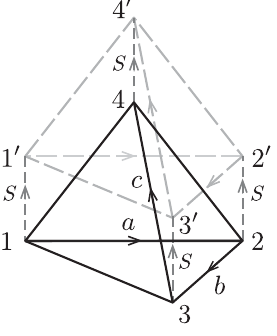
c; b; a Þ corre- s ð